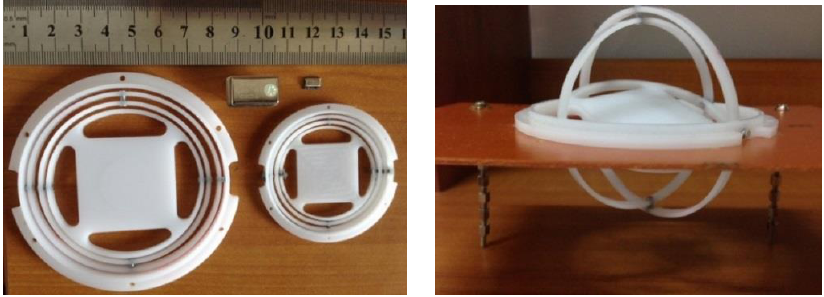
Figure 3. Modeling of gyroscopic mounting instrument. ( a ) Gyroscopic-mounting; ( b ) Dynamic load applied; ( c ) Mounting on PCB.